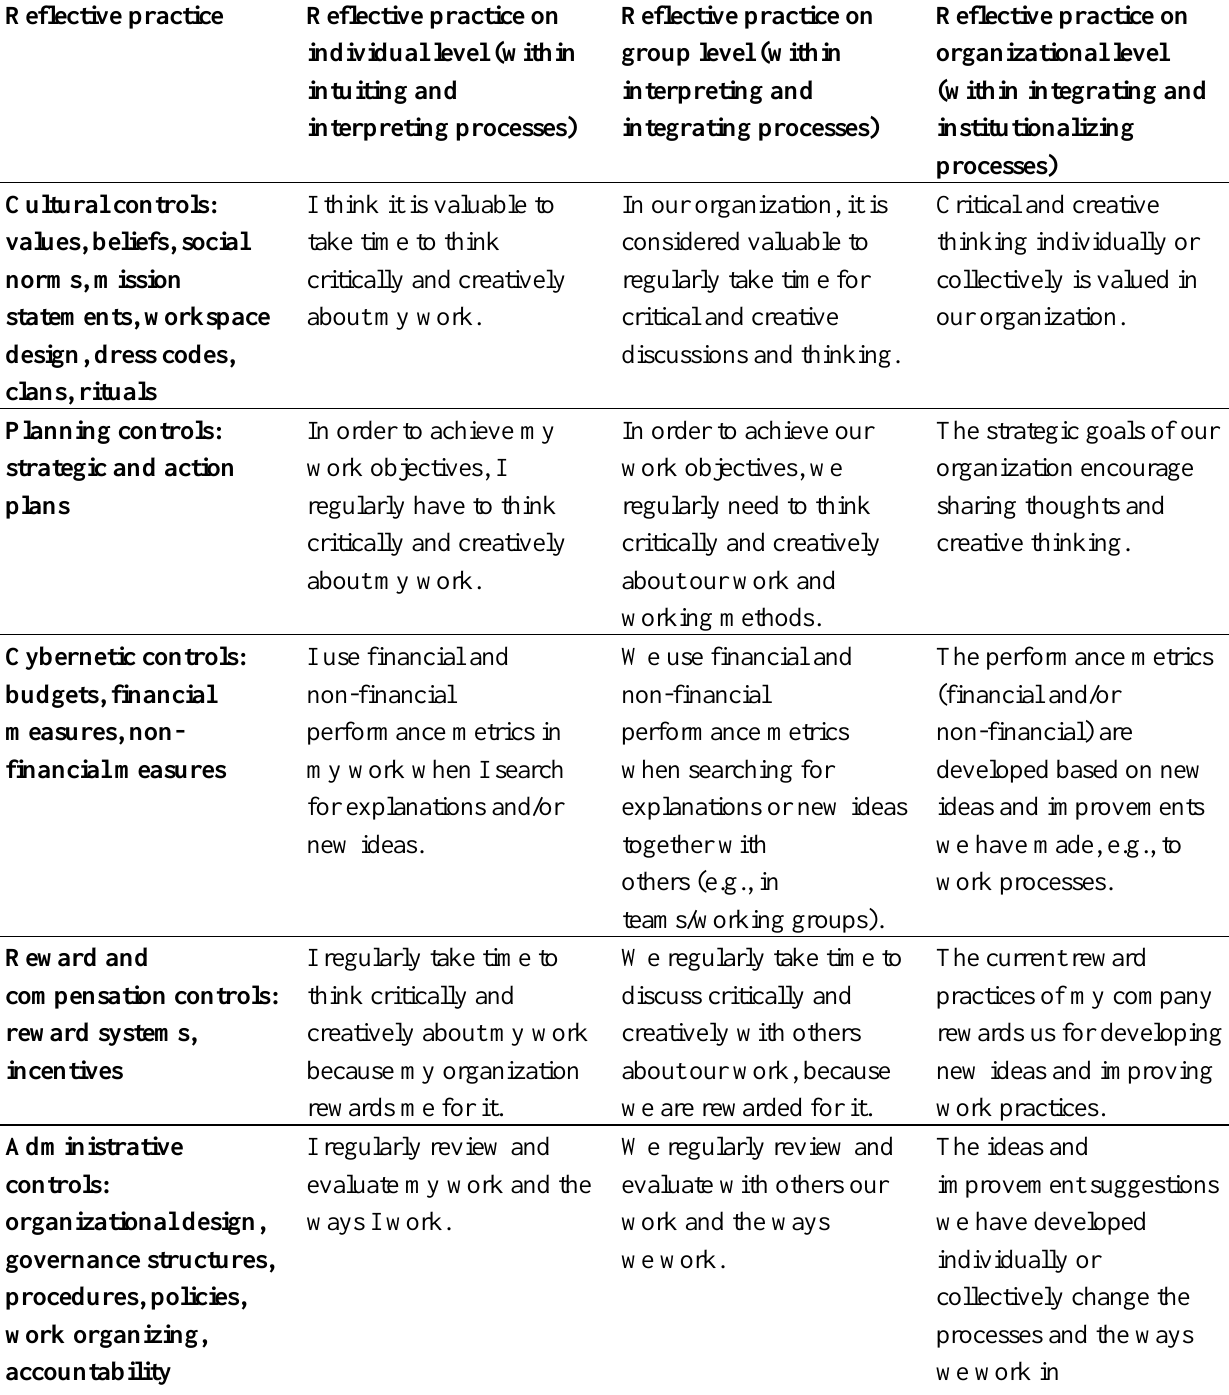
Table 1. The questionnaire for reflective practice reflected against management